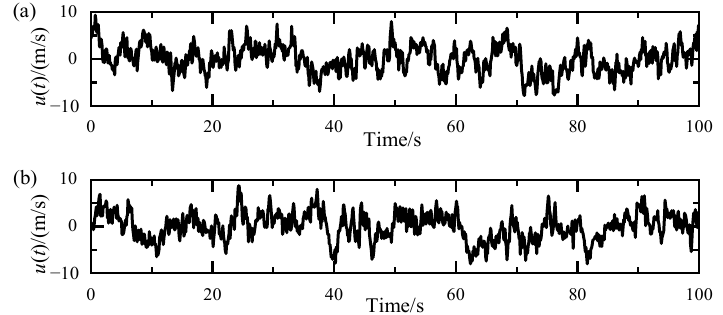
Figure 17. Simulated longitudinal wind turbulences of a moving train using different methods ( U = 20 m/s, α = 90°, V = 300 km/h, V R = 85.7 m/s, β = 13.5°): ( a ) an interpolating approach; ( b ) a moving point approach. Figure 16. Diagram of a moving point and equivalent point in the Taylor’s frozen flow field.